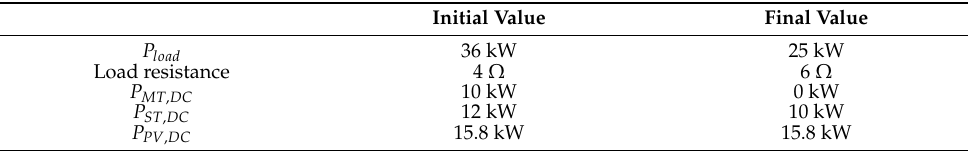
Table 12. Power production variation to achieve the objective.